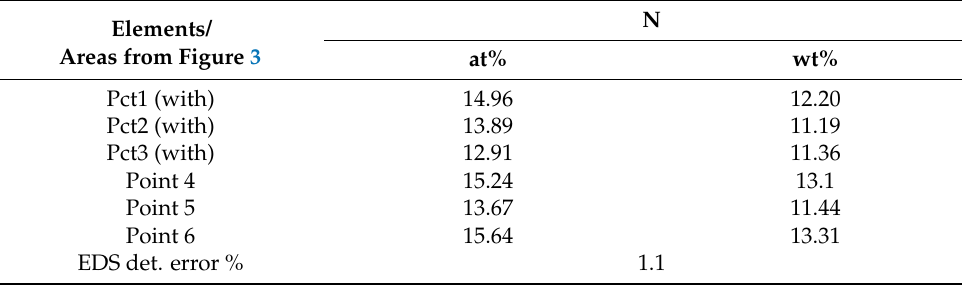
Table 10. Chemical composition of the areas selected in Figure 3a in wt and